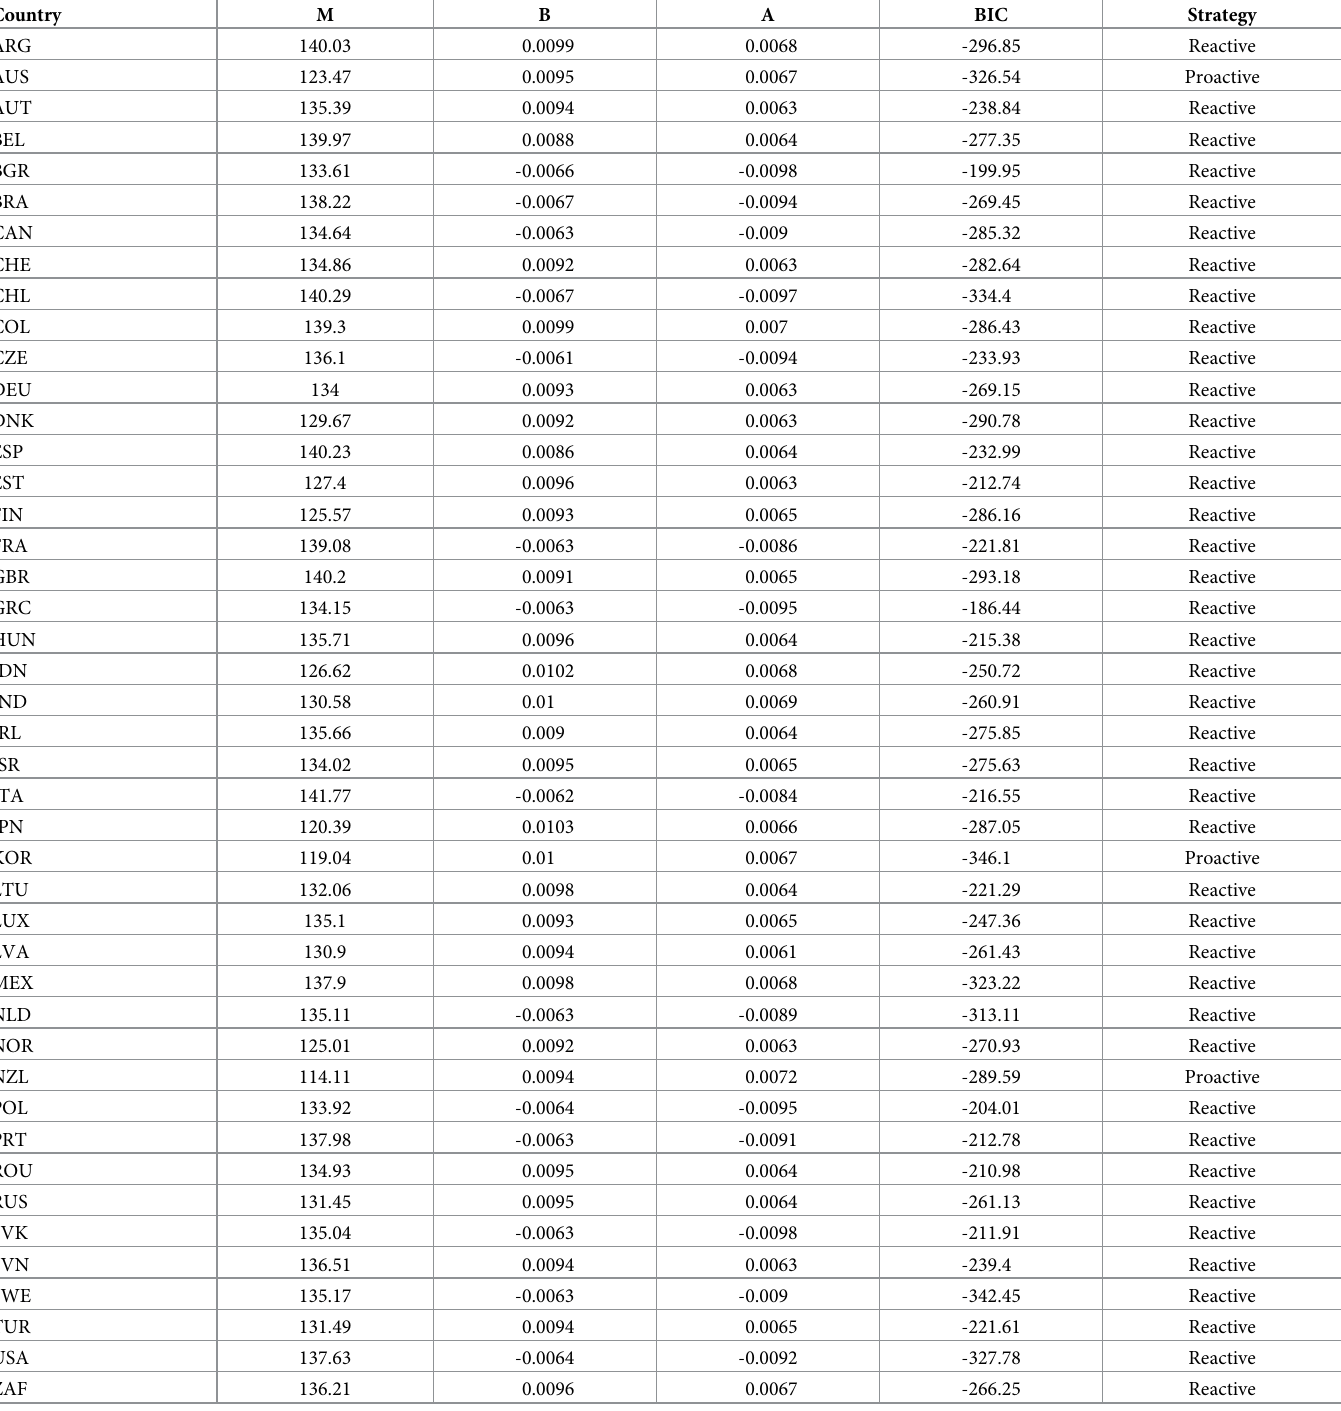
Table 1. Model parameters. Numerical estimates of model parameters for each country, obtained by non-linear least squares analysis on the log transformation of the global shock index. BIC indicates the Bayesian Information Criterion indicator. Country